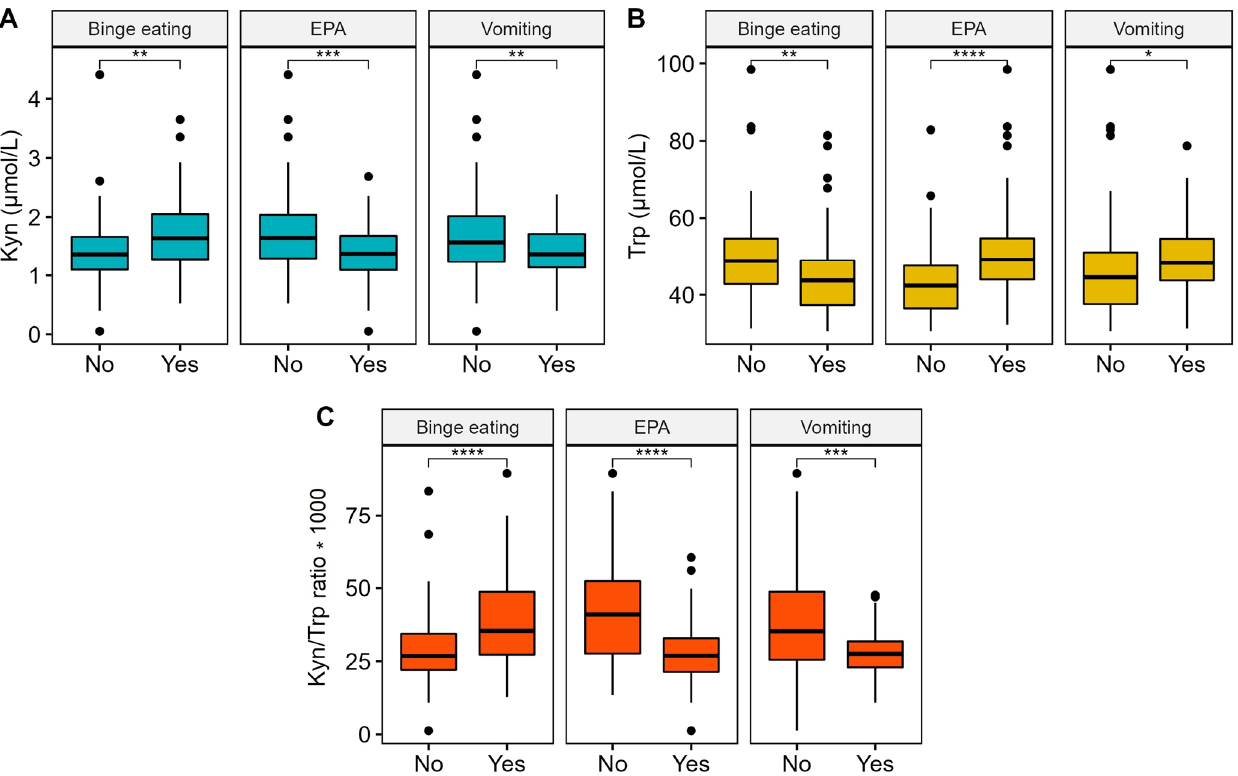
Figure 2. Boxplot and Mann–Whitney U test for Kyn (Panel A), Trp (Panel B), and the Kyn/Trp ratio (Panel C) with vomit, excessive levels of physical activity (EPA), and binge eating behavior. Significance code: * p < 0.05, ** p < 0.01, *** p < 0.001, **** p < 0.0001.